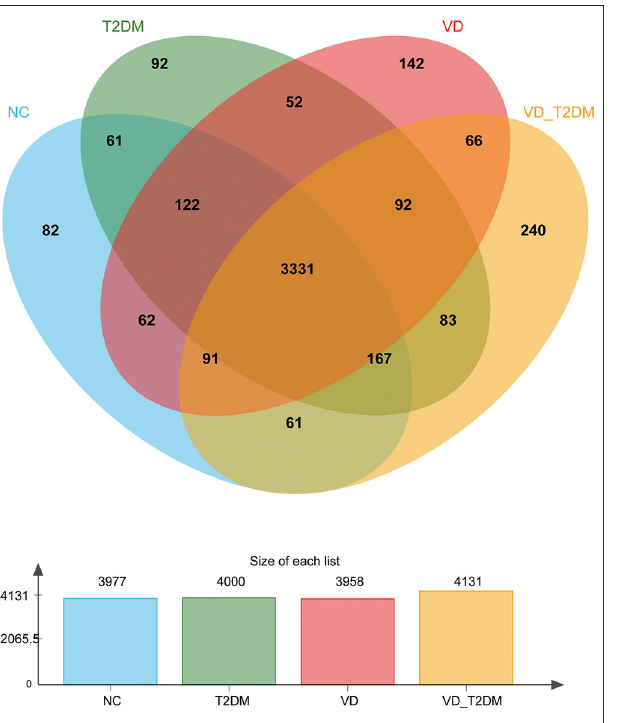
FIGURE 2 | A Venn diagram illustration of the urinary proteins identified in normal controls (NC), type 2 diabetes mellitus (T2DM), vascular dementia (VD), and VD + T2DM groups. Representative Venn diagrams show common proteins found in pooled urine-enriched fractions from patients with DM + VD ( n = 10), patients with VD ( n = 12), patients with DM ( n = 20), and normal controls ( n =